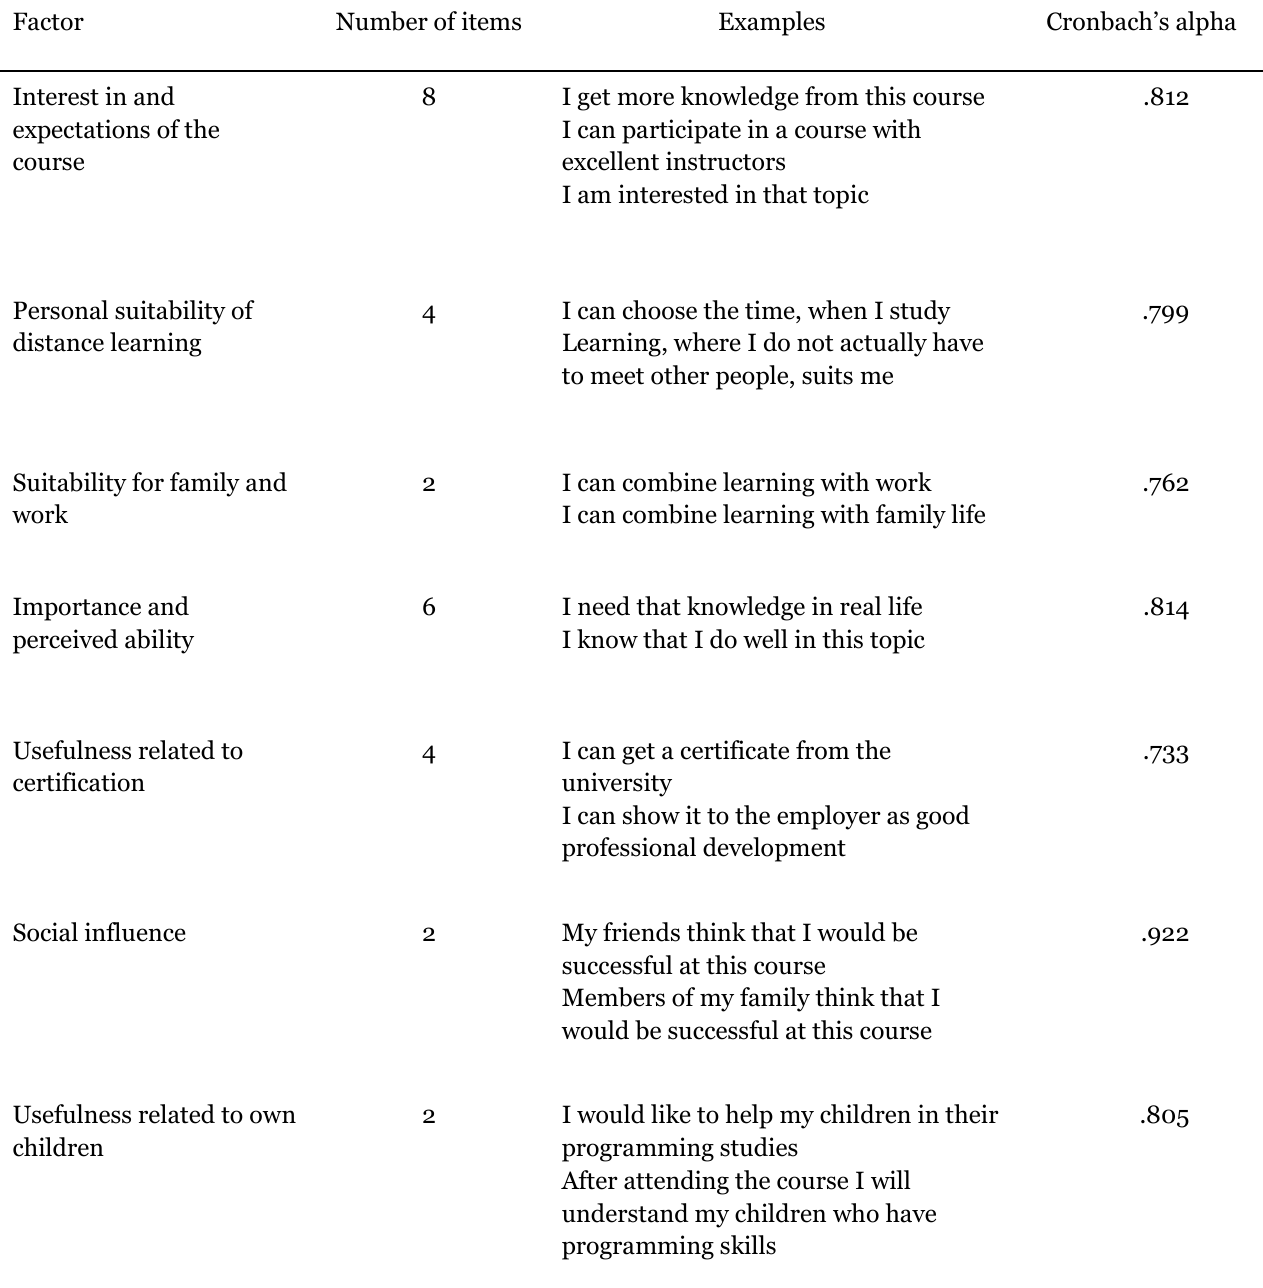
Table 1 Description of the Questionnaire Instrument Factor Number of items Examples Interest in and expectations of